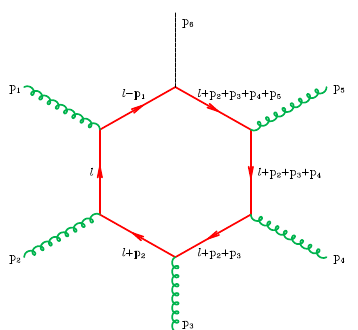
Figure 3 . Feynman diagram to illustrate the calculation of the coefficient of the scalar integral E 0 ( p 1 , p 2 , p 3 , p 4 ; m